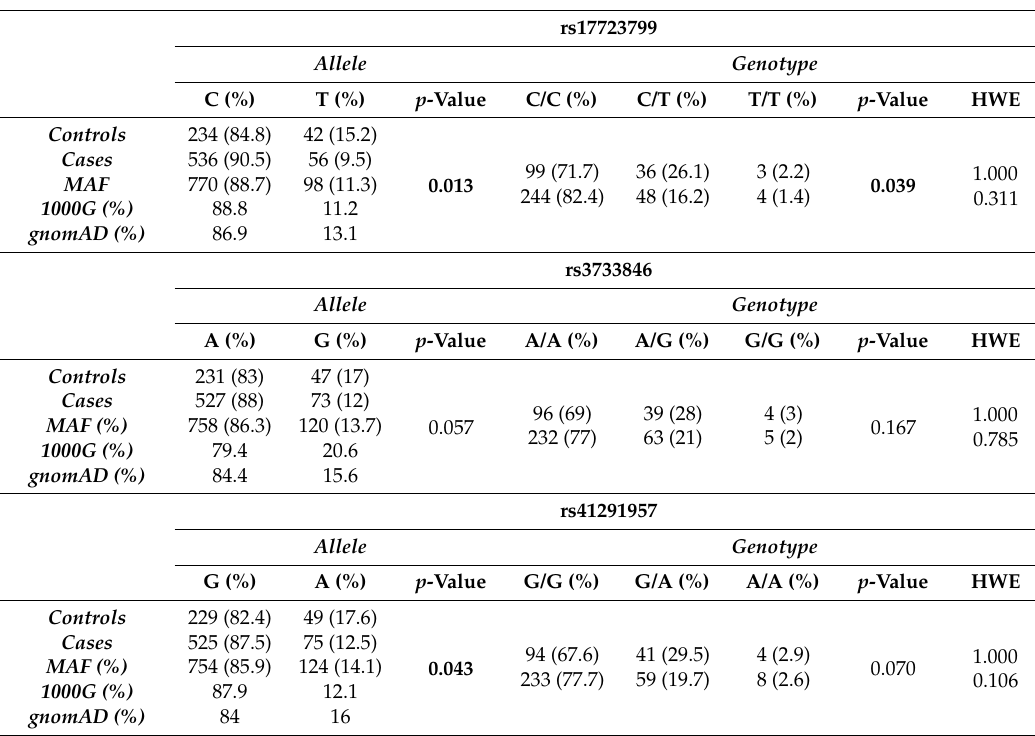
Table 5. Allele and genotype frequencies of SNPs located in MIR143 in the GLP-NHL case and control populations in comparison to allele frequencies obtained from HapMap 1000G and gnomAD databases. HWE, Hardy-Weinberg Equilibrium (HWE) test